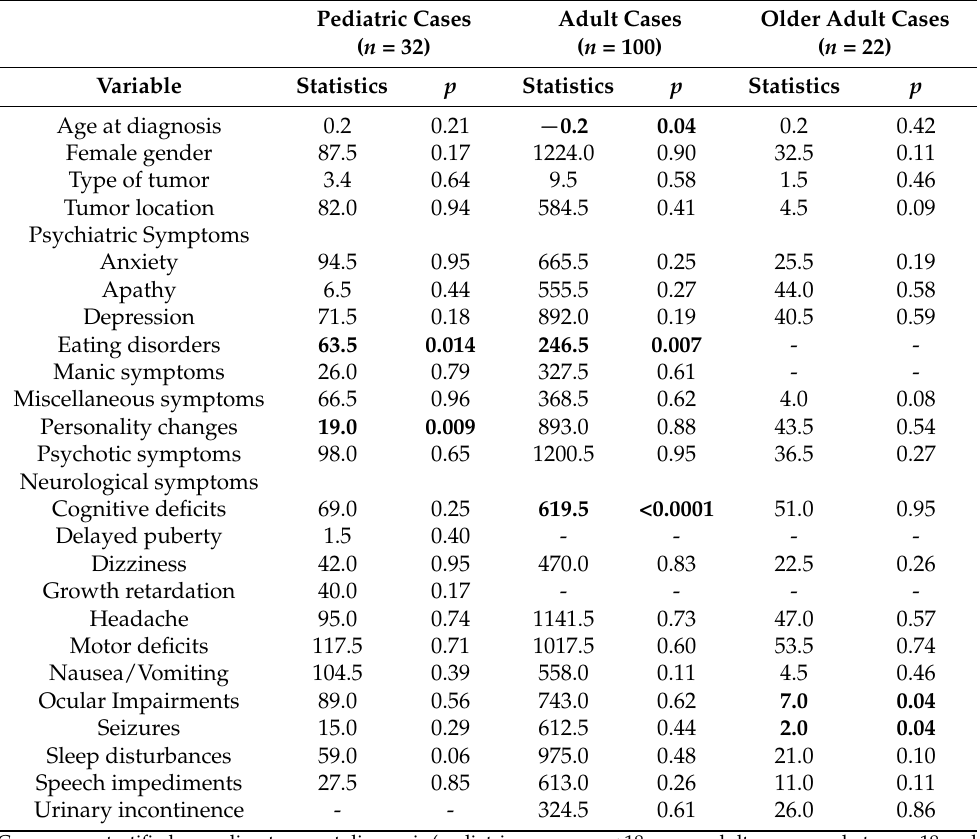
Table 4. Association between clinical characteristics and time from onset of symptoms to